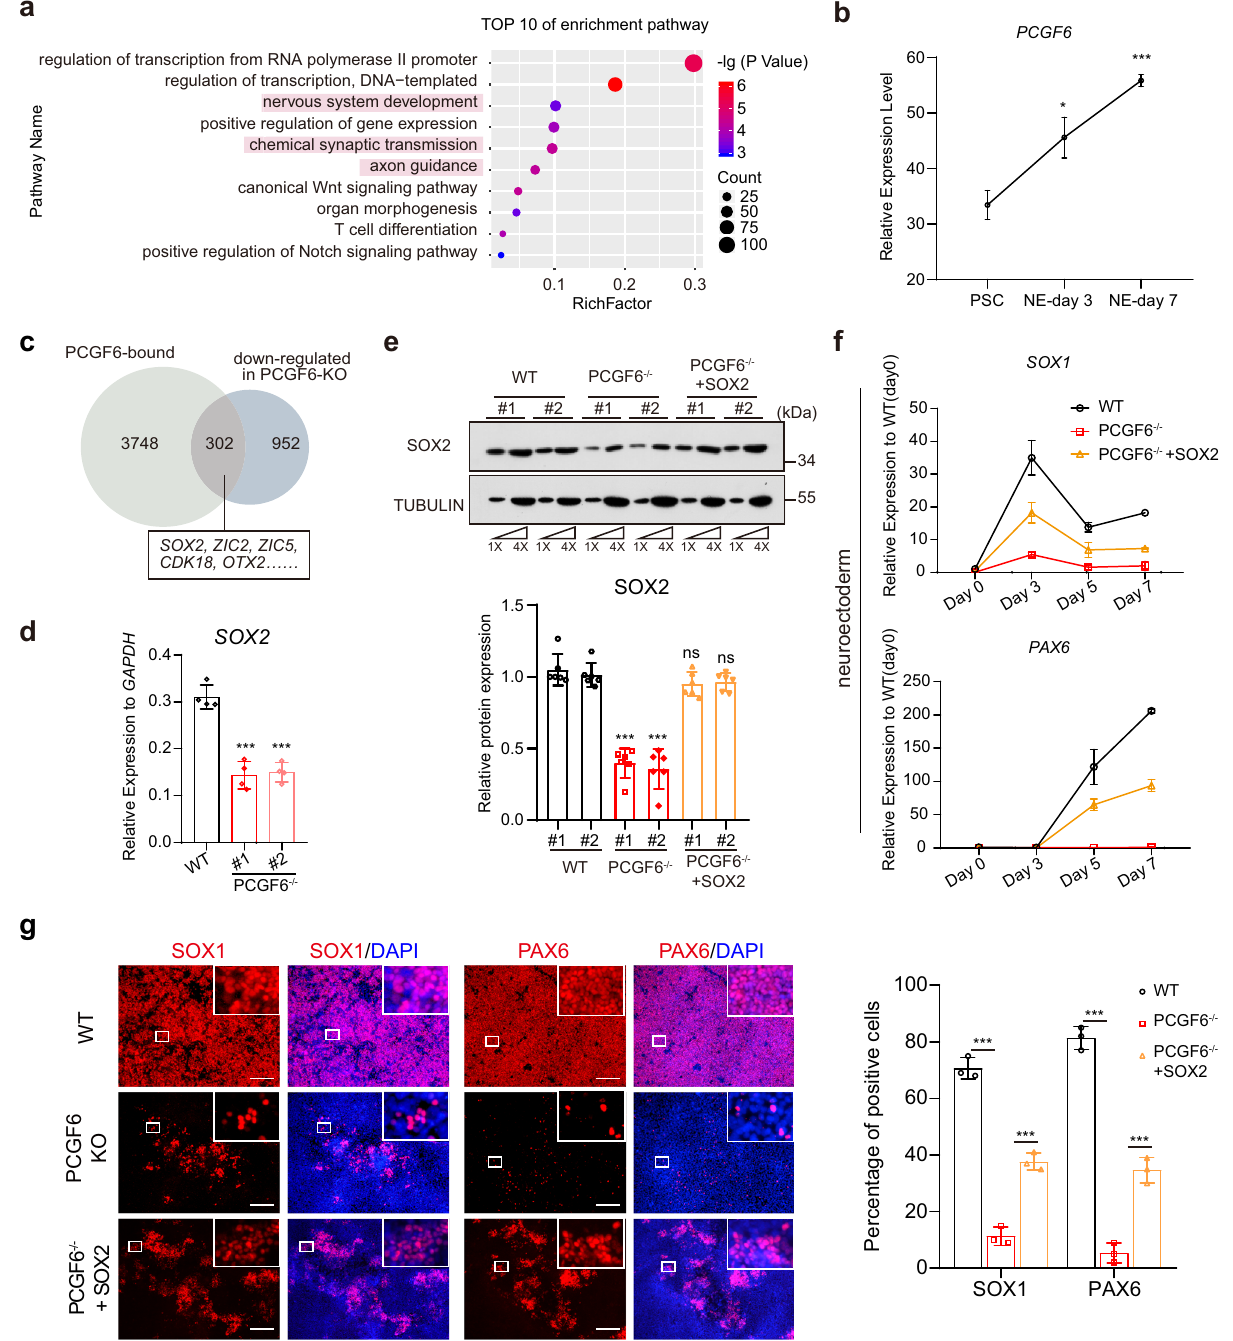
Fig. 4 | PCGF6isrequired forneuroectoderm differentiation fromhumanPSCs throughregulatingSOX2.a GOenrichmentandKEGGpathwayanalysisofPCGF6- bound genes. b Expression analysis of PCGF6 during neural differentiation ( n =3). c Venn diagram shows the overlap of PCGF6-binding genes and downregulated genes in PCGF6-KO cells, revealing SOX2 and its downstream genes as potential direct targets of PCGF6. d Relative expression levels of SOX2 in the WT and PCGF6-KO human PSCs ( n =3). e Protein level of SOX2 in WT, PCGF6-KO and PCGF6 − / − +SOX2 (PCGF6-KO/SOX2-overexpressing) human PSCs was determined and quanti fi ed; TUBULIN was used as a loading control ( n =3). f qRT-PCR analysis